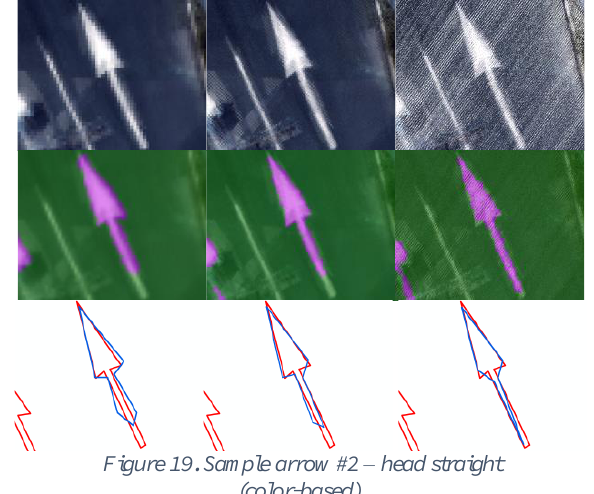
Figure 19. Sample arrow #2 – head straight (color-based).